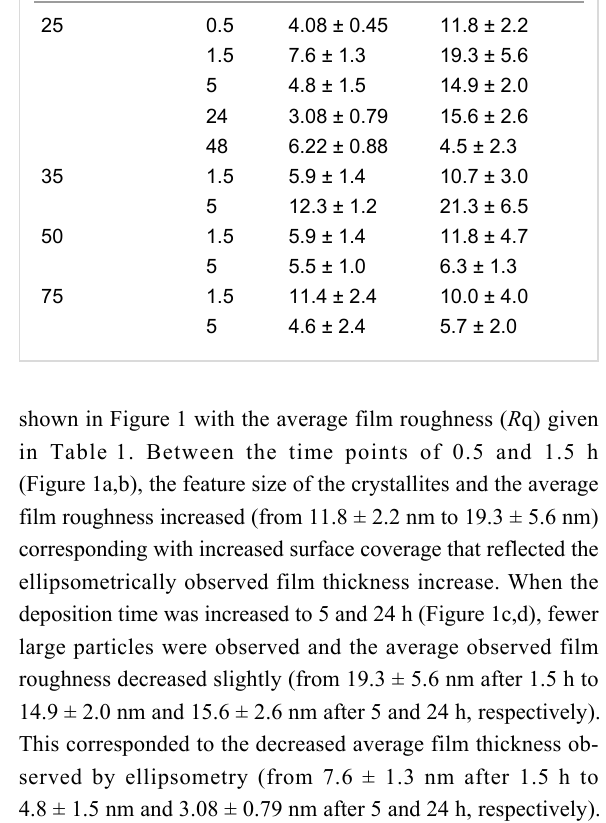
Table 1: Average film thickness and roughness values along with stan- dard deviations observed for specified codeposition conditions. temperature